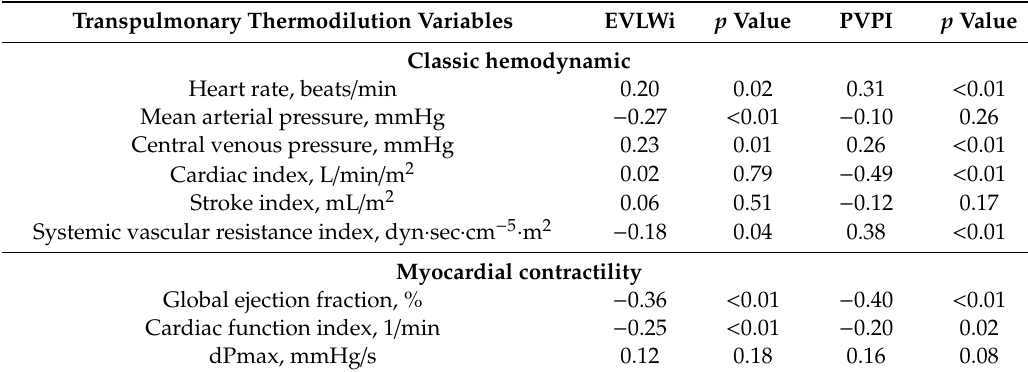
Table 3. Pearson correlations between pulmonary edema (PE) and hemodynamic variables. PE variables are the extravascular lung water index (EVLWi) and pulmonary vascular permeability index (PVPI). Hemodynamic variables are categorized as classic hemodynamic, myocardial contractility, cardiac preload, and fluid responsive prediction variables. dPmax is the maximal change of arterial pressure per